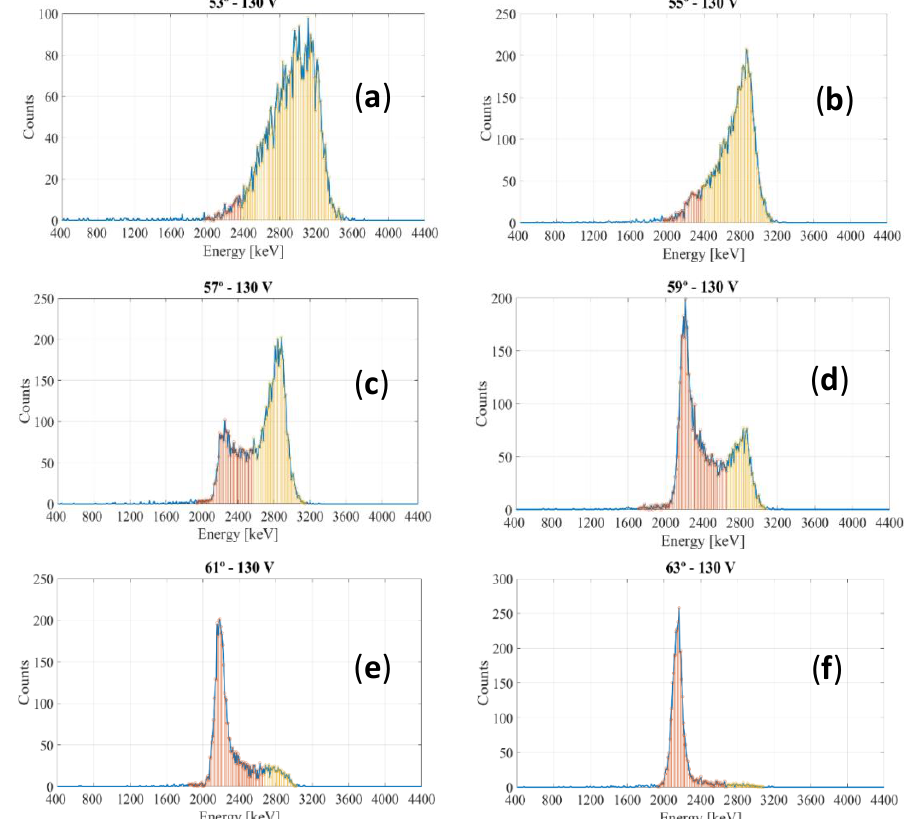
Figure 15. IBIC measurements at 130 V around the critical angle. ( a ) 53°; ( b ) 55°; ( c ) 57°; ( d ) 59°; ( e ) 61° and ( f ) 63°. The number of protons that stop within the active volume and the number of protons that are transmitted are represented in red and yellow colors, respectively.